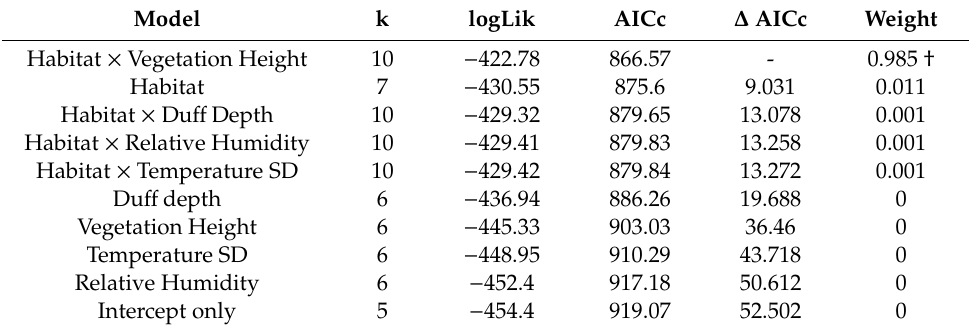
Table 6. Parameter estimates for the model used to analyze the effects of habitat and vegetation height on the abundance of A. americanum nymphs.